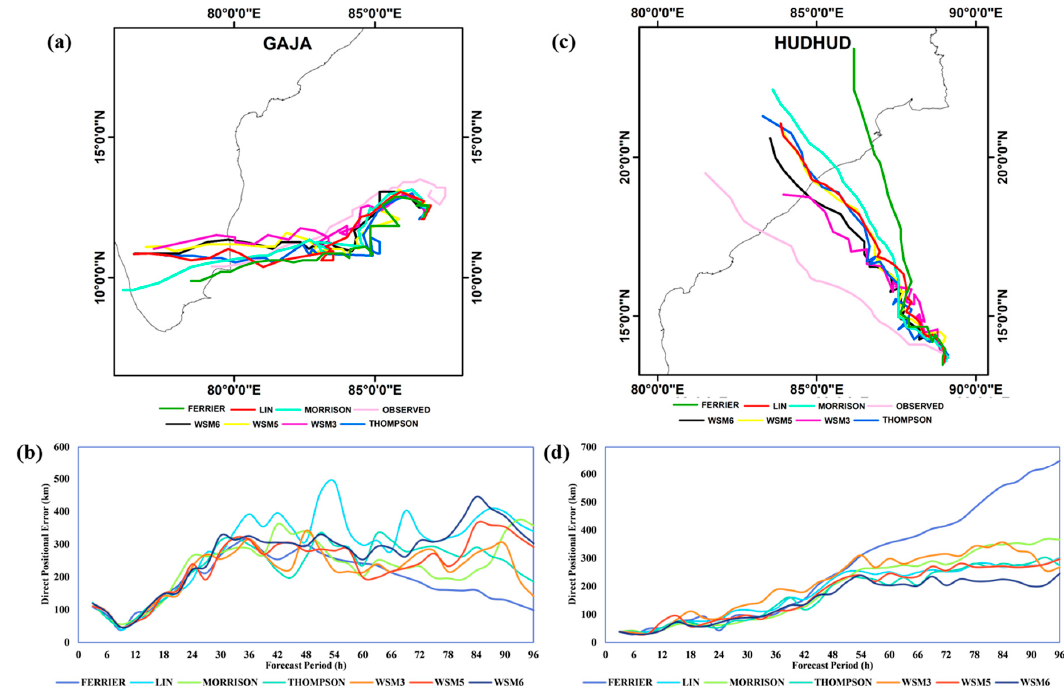
Figure 4. Observed and predicted tracks of tropical cyclones initiated at cyclonic stage (Gaja) and severe cyclonic stage (Hudhud) along with DPE ( a ) track of Gaja Cyclone, ( b ) DPE of Gaja Cyclone, ( c ) track of Hudhud Cyclone, ( d ) DPE of Hudhud Cyclone.